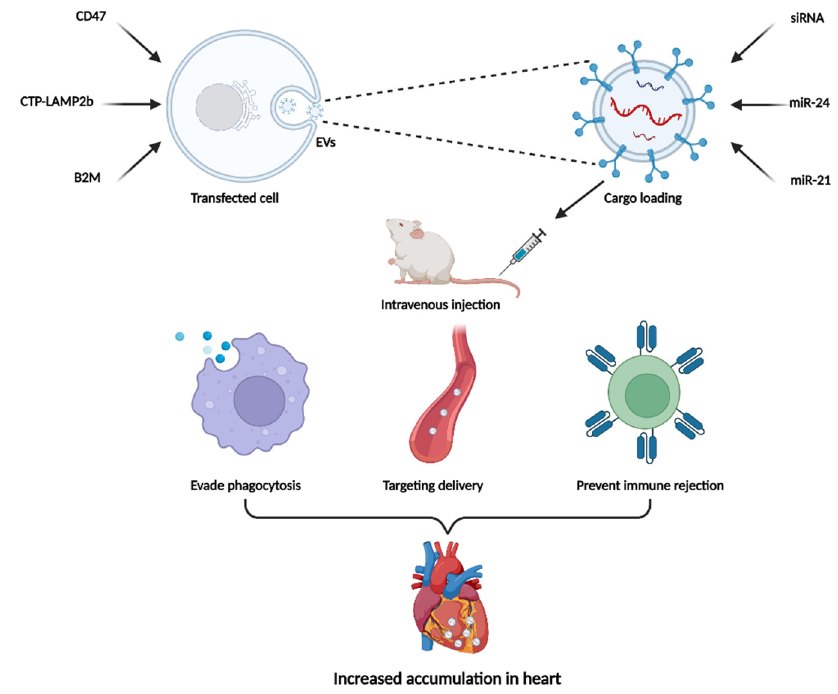
Figure 3. Two-step EVs delivery method for cardiac therapies. Two-step EVs delivery method works by genetically modifying the parent cell followed by the loading of the therapeutic cargos. CTP-Lamp2b, CD47, and B2M-modified EVs were loaded with siRAGE, miR-21, and miR-24 to impart the property of targeting delivery, evading phagocytosis and preventing immune rejection,